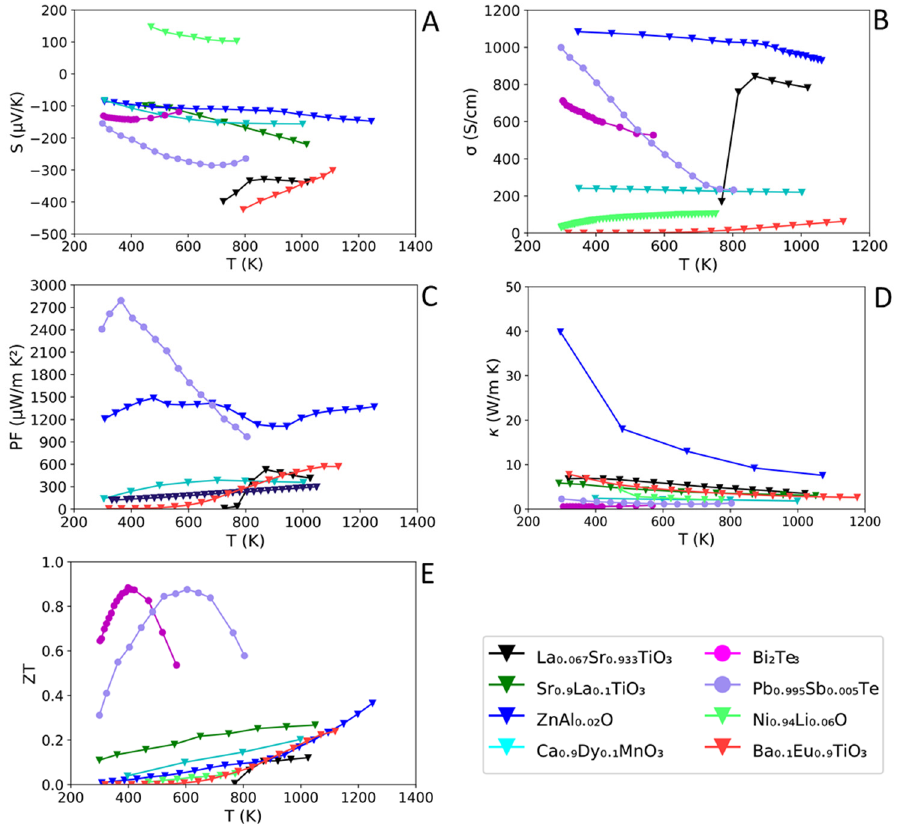
Figure 3. Comparison S ( A ), σ ( B ), PF ( C ), κ ( D ) and ZT ( E ) for a number of inorganic TE materials from Table 2 as a function of temperature (K). La 0.067 Sr 0.933 TiO 3 [31], Sr 0.9 La 0.1 TiO 3 [77], Zn 0.998 Al 0.02 O [23], Ca 0.9 Dy 0.1 MnO 3 [26], Bi 2 Te 3 [75], Pb 0.995 Sb 0.005 Te [74], Ni 0.94 Li 0.06 O [79], and Ba 0.1 Eu 0.9 TiO 3– δ [39]. CaMnO 3 has not yet been used within composite materials but is a popular TE candidate.